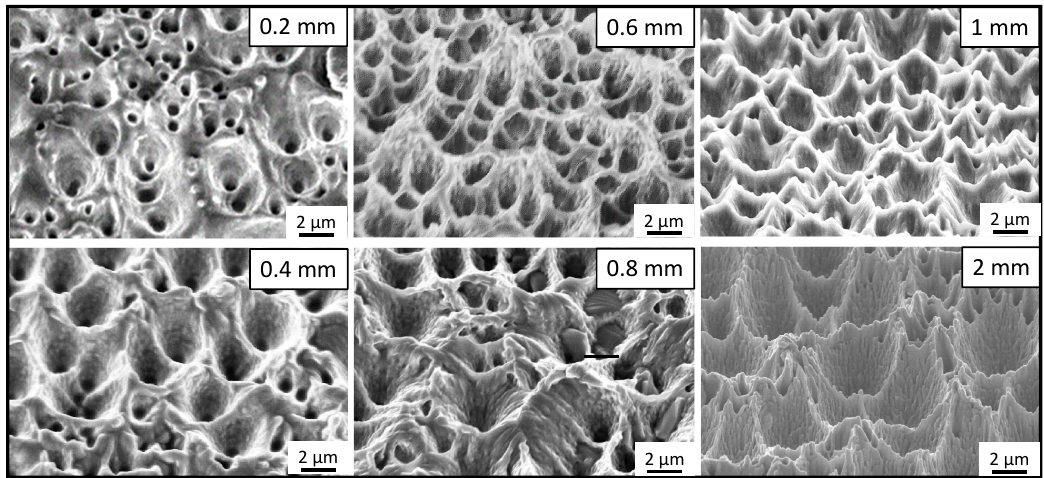
Figure 2. Scanning electron micrographs of PDMS substrates with thickness of 0.2 mm, 0.6 mm, 0.4 mm, 0.8 mm, 1 mm and 2 mm, indicating that the thicker the PDMS substrate is, the more detailed features able to be replicated